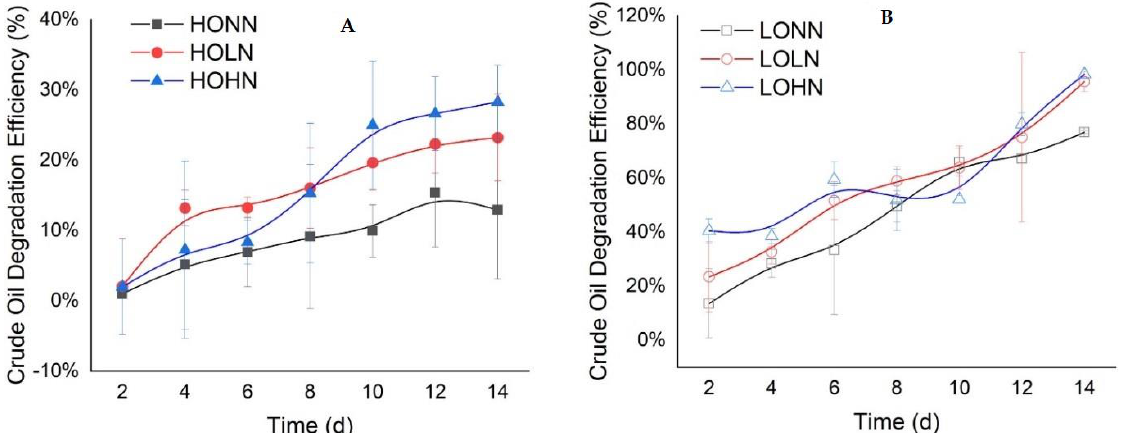
Figure 3. Biodegradation efficiency of crude oil with nutrient addition over 14 days of incubation. Three experiments with high oil concentration of oil 10 g/L are illustrated in ( A ), first with high oil concentration with no added nutrient (HONN), second with high oil concentration with low nutrients added (0.02 g/L of nutrient) (HOLN), and lastly, high oil concentration with high nutrients added (2 g/L of nutrients) (HOHN). Similarly, three experiments with a low oil concentration of 0.01 g/L of crude oil are illustrated in ( B ) low oil concentration with no nutrient added (LONN), low oil concentration with low nutrients added (0.02 g/L nutrients) (LOLN), and lastly, low oil concentration with high nutrients added (2 g/L nutrients) (LOHN). Adapted from Chen et al. [7].